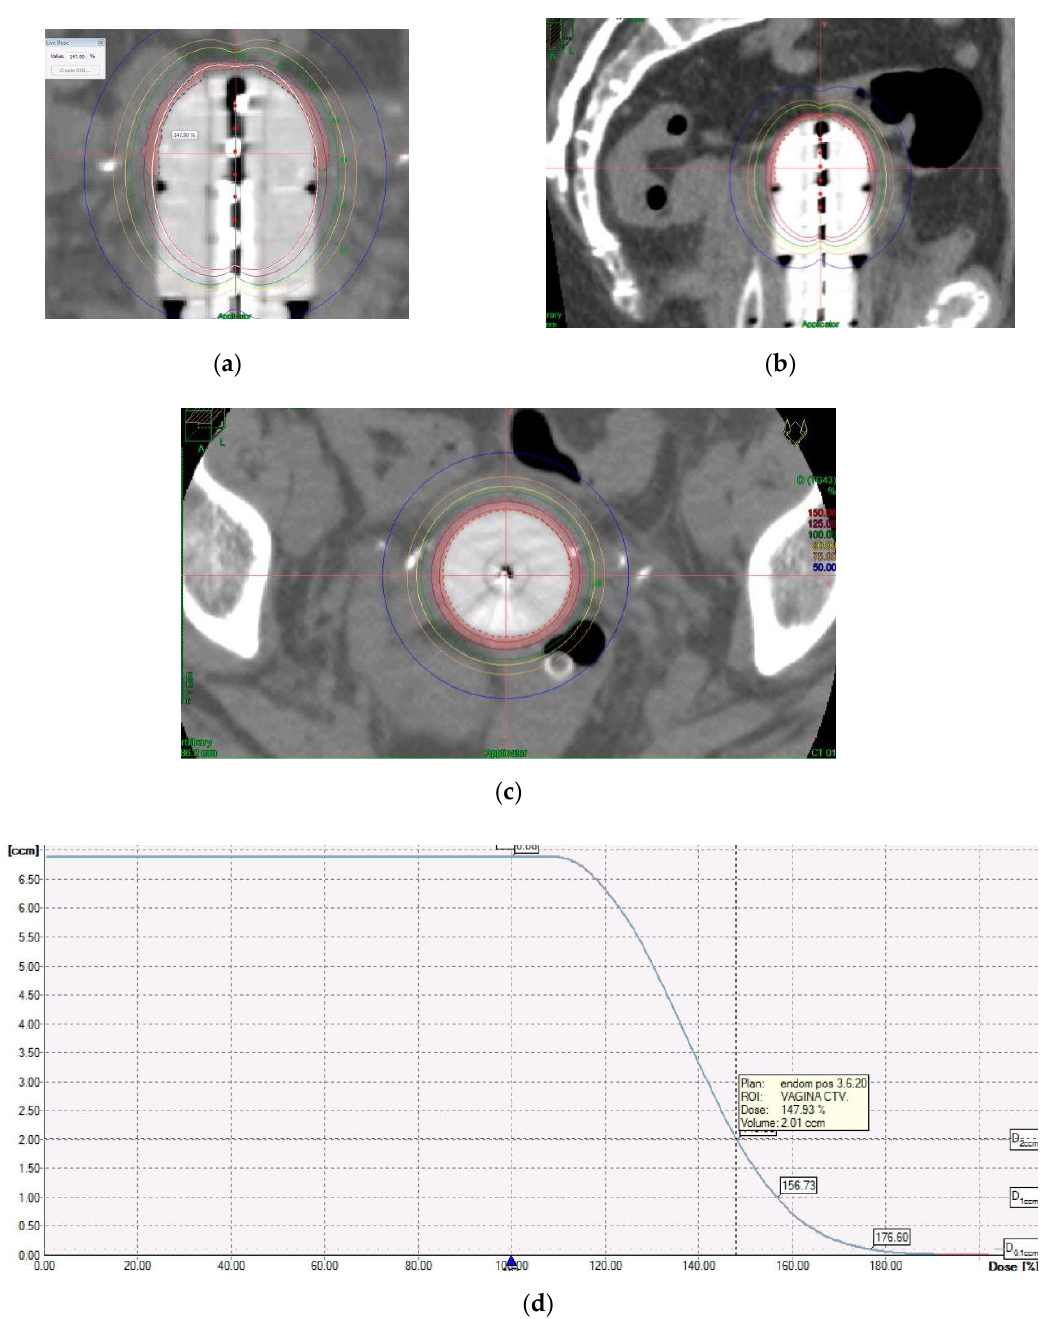
Figure 3. Example of dosimetric study showing the most exposed 2 cm 3 of vagina to the dose in coronal ( a ), sagittal ( b ) and axial ( c ) planes and ( d ) dose volume histogram.